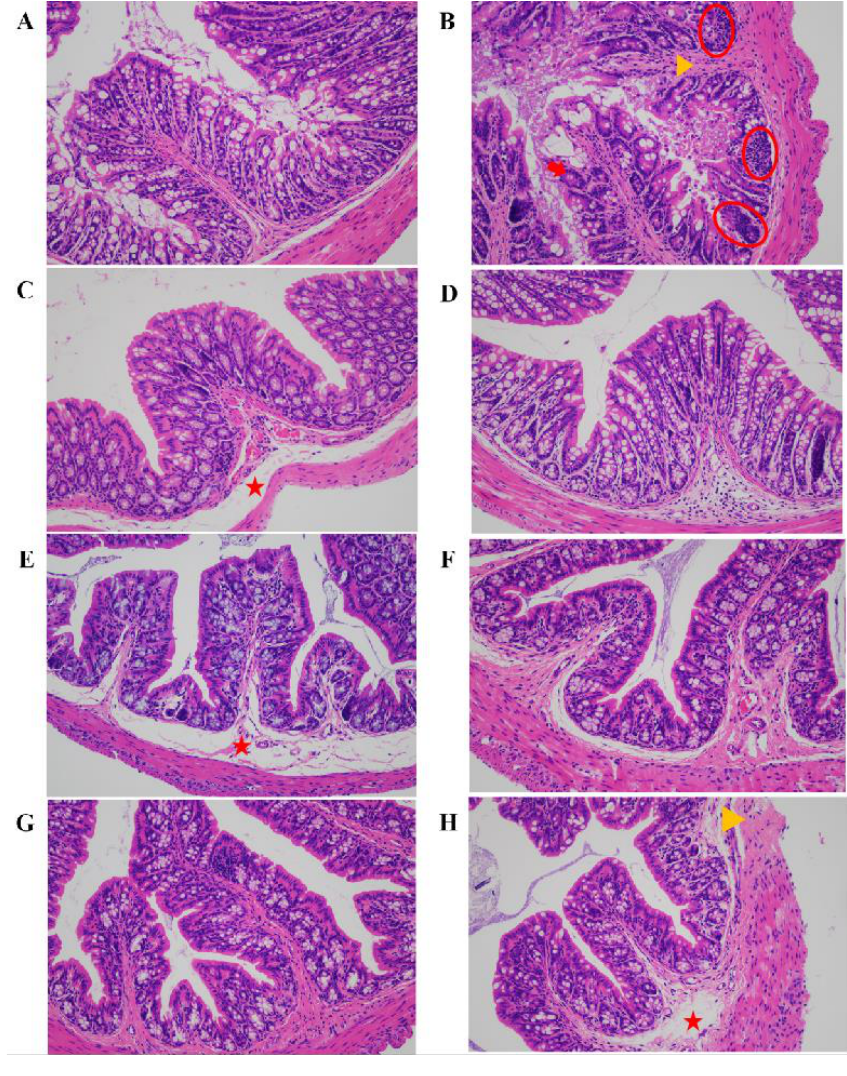
Figure 4. Effect of FECs supplementation on histopathological changes by H&E staining in DSS- induced mice colon, × 200 magnifications. ( A ) CON group; ( B ) DSS group; ( C ) FMA group; ( D ) ISO group; ( E ) CA group; ( F ) FA group; ( G ) SFN group; ( H ) CGA group. Inflammatory cells infiltration (red circle), crypt structure damage (red arrow), upper mucosa deformation (yellow triangle), submucosa edema (red star).